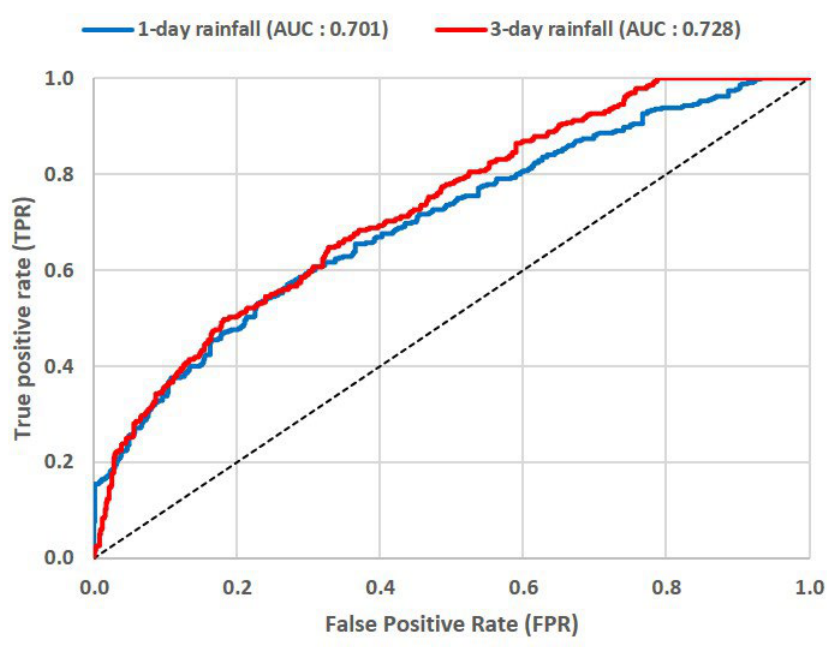
Figure 6. AUC results for 1-day and 3-day effective antecedent rainfall .